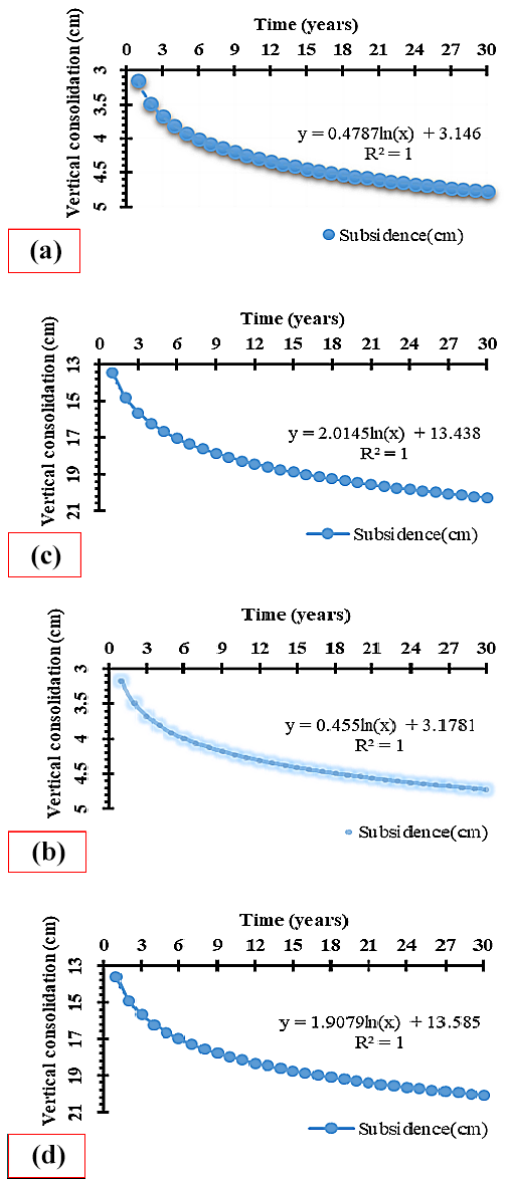
Figure 3. Graphical representation of vertical consolidation against time in